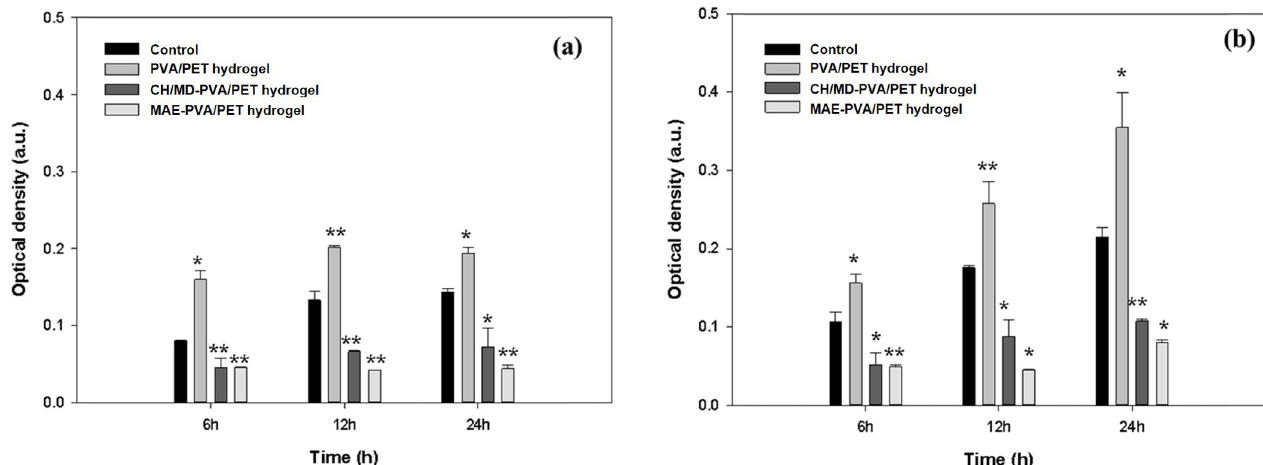
Fig 2. Antimicrobial evaluation. Antimicrobial activity of the Melia azedarach extract (MAE)-poly(vinyl alcohol)/pectin (PVA/PET) hydrogel at different exposure times against (a) Staphylococcus aureus and (b) Staphylococcus epidermidis . � p < 0.05, �� p < 0.01 with control and experiment.